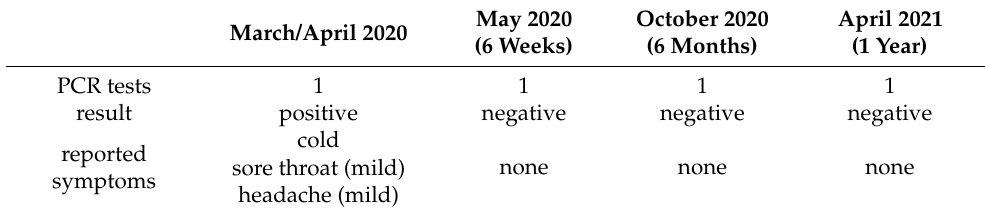
Table 1. PCR test results and reported